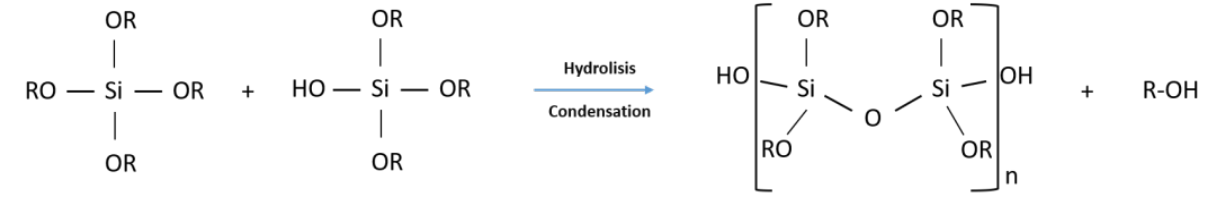
Figure 2. Illustration of the reaction of silicon alkoxides to form a silica network. R = alkoxy.